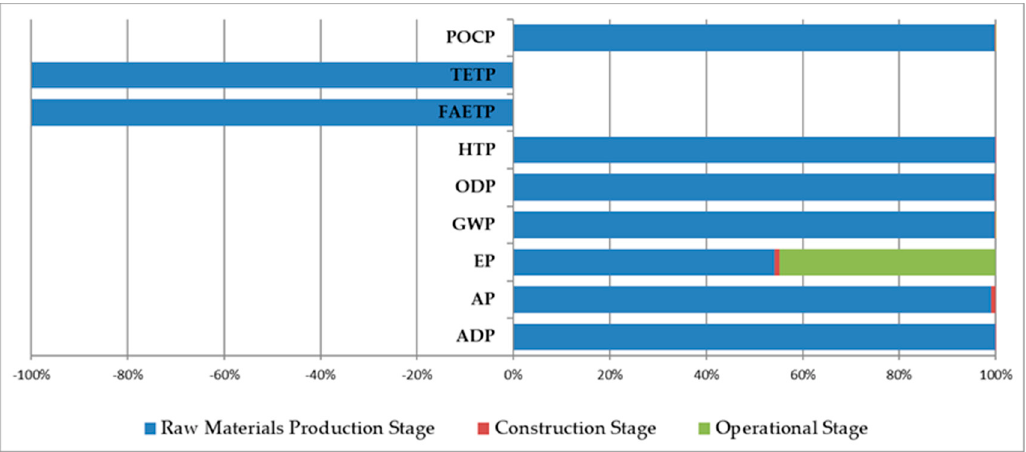
Figure 3. Relative contributions of FW life cycle stages per category of impact. ADP: abiotic depletion potential, AP: acidification potential, EP: eutrophication potential, GWP: global warming potential, POCP: photochemical oxidation poten-